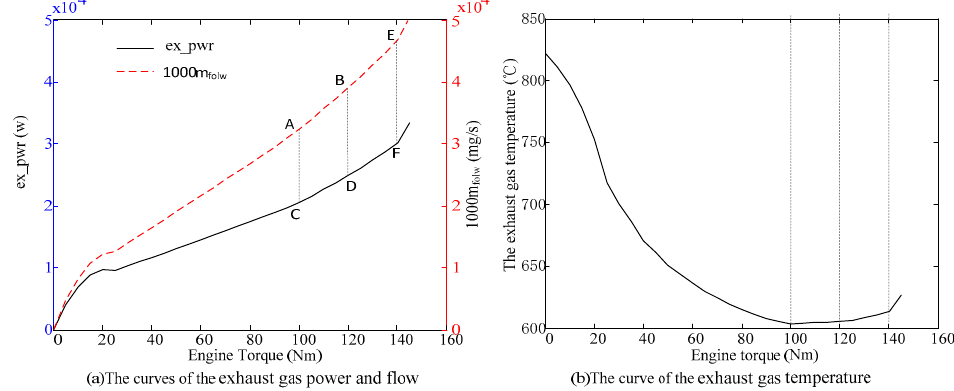
Figure 7. The curves of the exhaust gas power, flow and temperature at 3000 rpm.